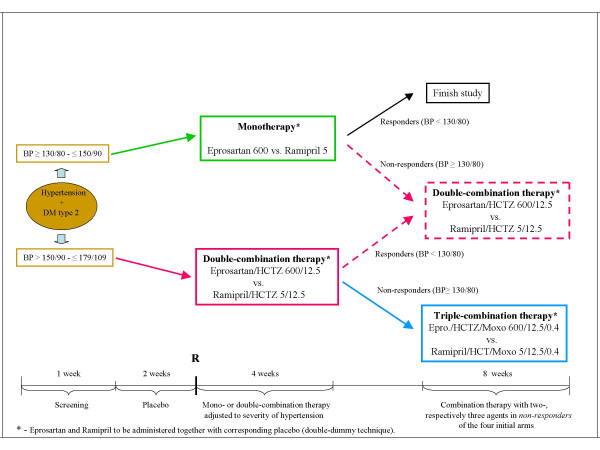
Treatment Algorithm